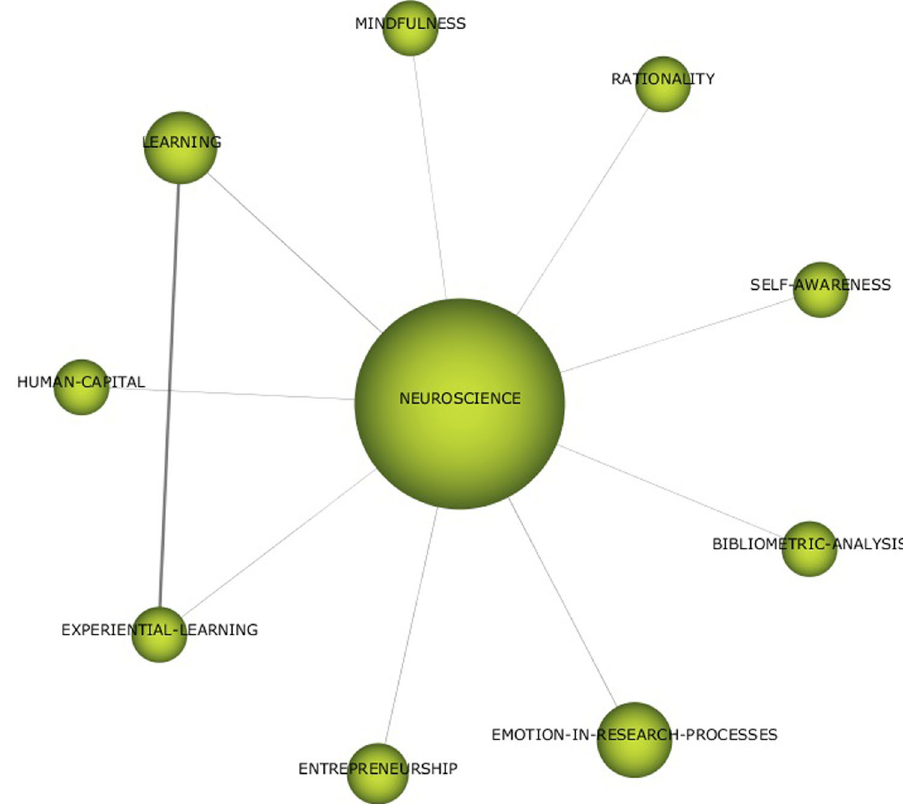
Fig. 2 Thematic network for NEUROSCIENCE (1992 – 2022). Results from SciMat, cluster network for Neuroscience (1992 –